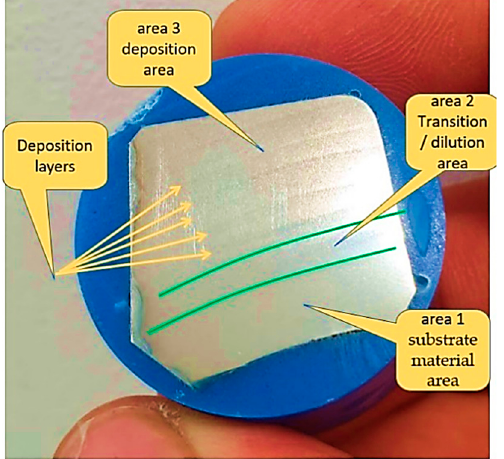
Figure 22. Highlighting microscopically analyzed areas.